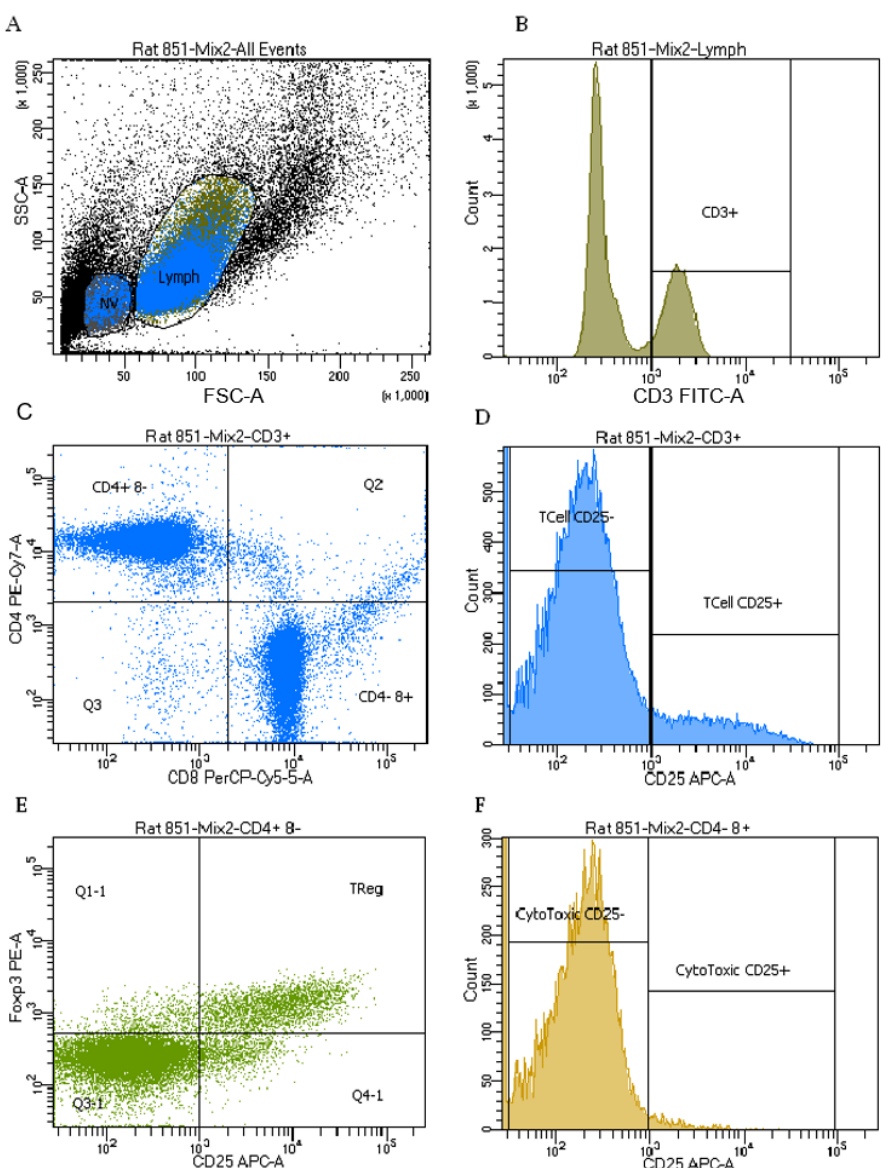
Figure 6. Immune cell phenotyping. ( A ) Definition of viable lymphocytes (Lymph) and non-viable lymphocytes (NV); ( B ) Definition of CD3 binding after gating on Lymph; ( C ) Definition of CD4 and CD8 after gating on CD3 + Lymph; ( D ) Definition of CD25 binding after gating on CD3 + Lymph; ( E ) Definition of Foxp3 and CD25 after gating on CD3 + CD4 + CD8 − Lymph; ( F ) Definition of CD25 binding after gating on CD3 + CD4 − CD8 +